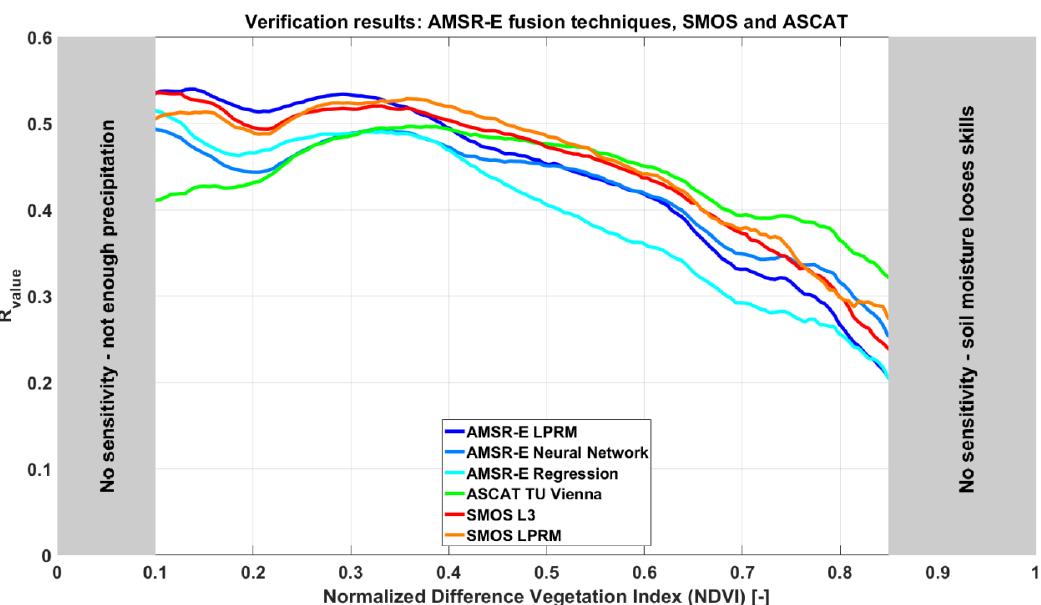
Figure 4. R value binned over the evaluated NDVI range for all 6 satellite soil moisture datasets, based on the three different fusion techniques and